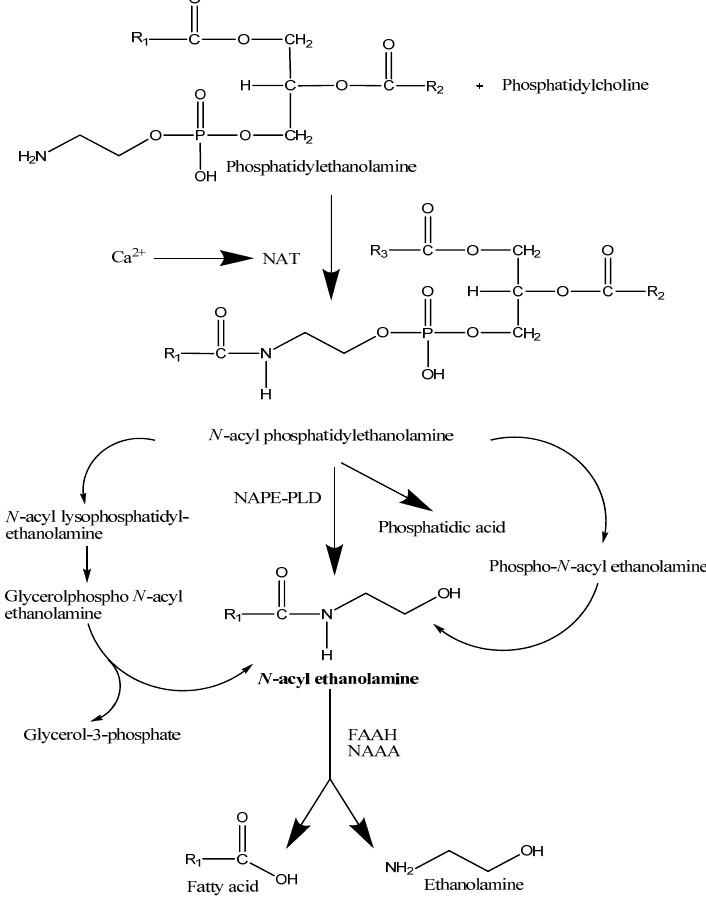
Figure 1. Proposed pathways for the synthesis and degradation of